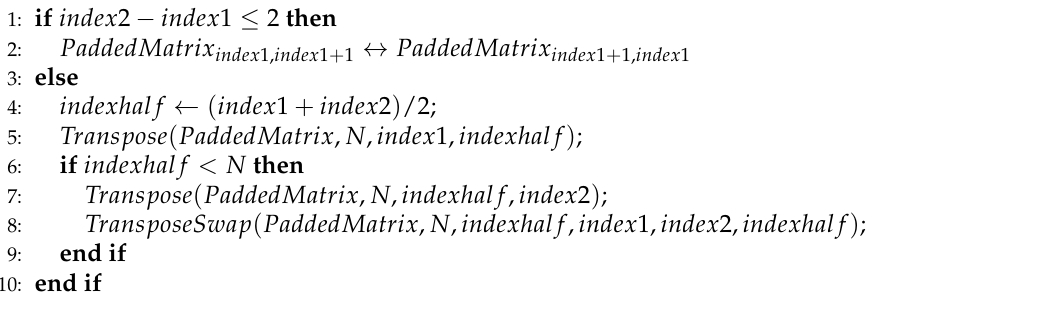
Algorithm 3 Transpose( PaddedMatrix , N , index 1 = 1, index 2 = N ): transposes a phantom-padded matrix, stored in row major order, recursively.